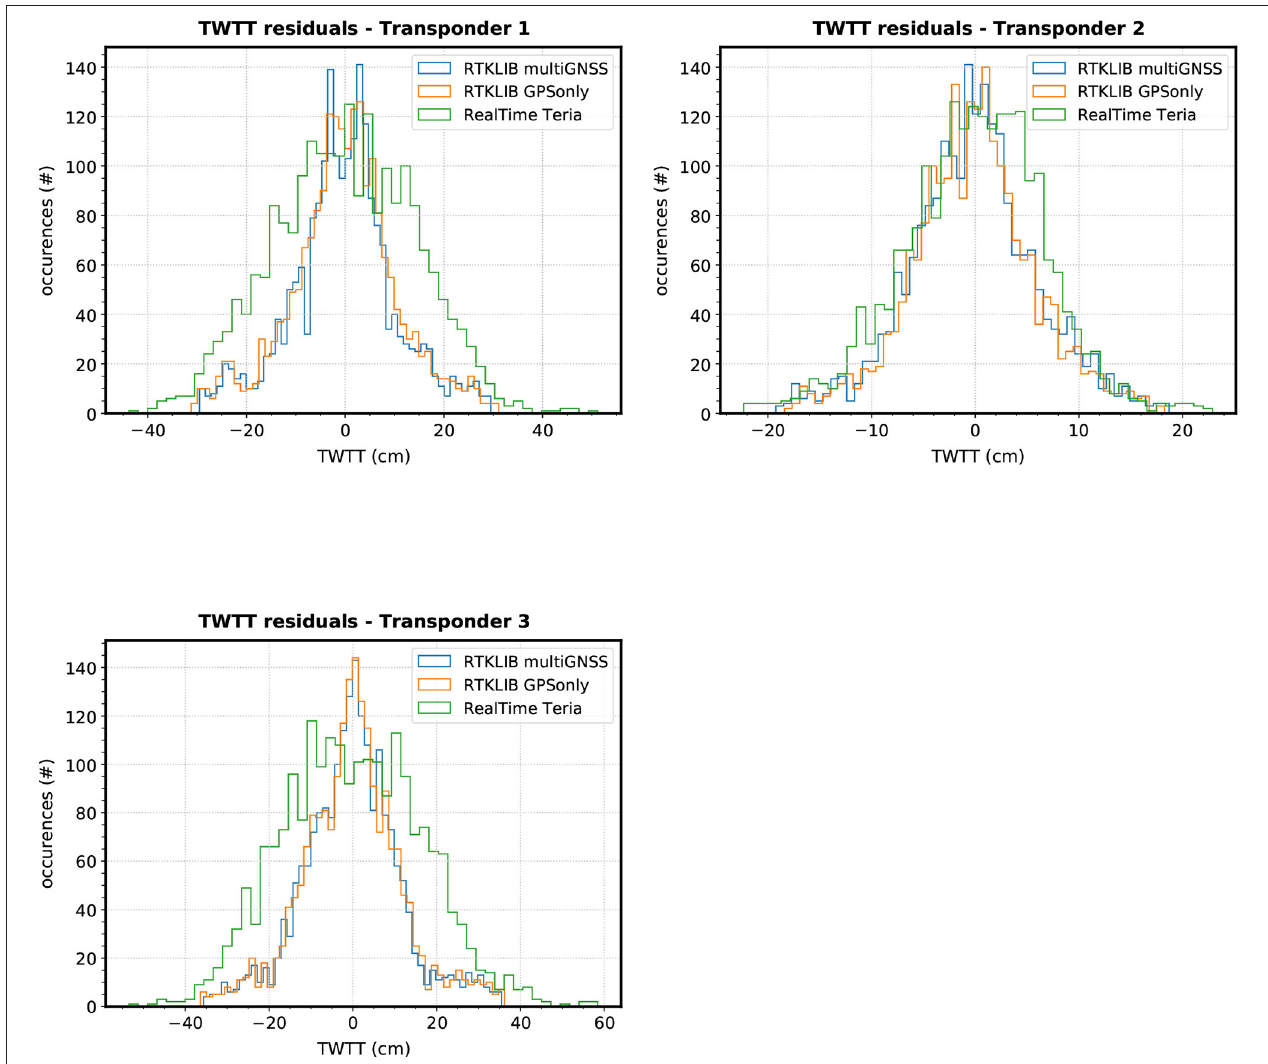
FIGURE 9 | Histograms of the TWTT residuals (converted to distance) based on the different GNSS solutions for the three transponders in box-in mode.